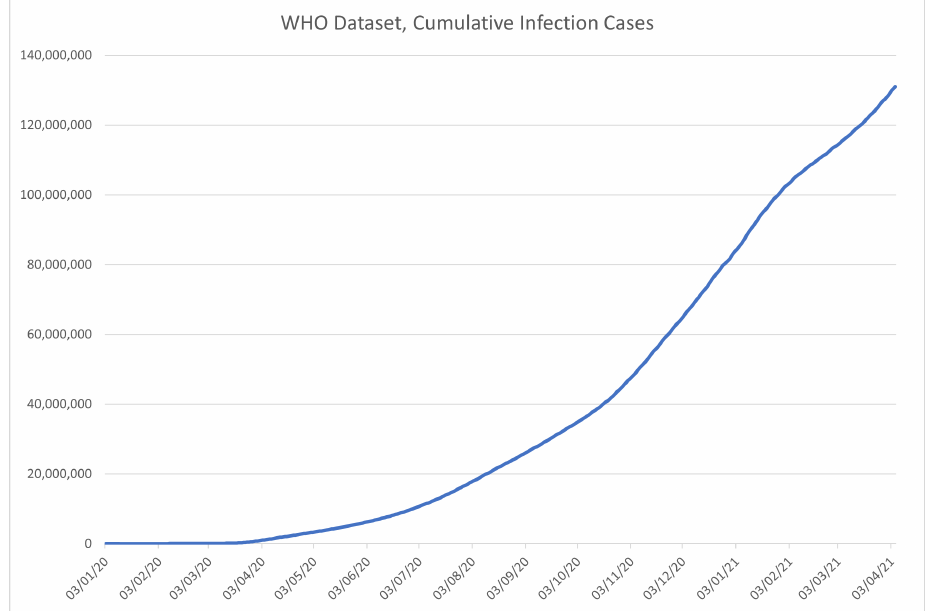
Figure 3. Time-series plot of the data in the WHO dataset, for the number of COVID-19 infections, contained within the dataset.